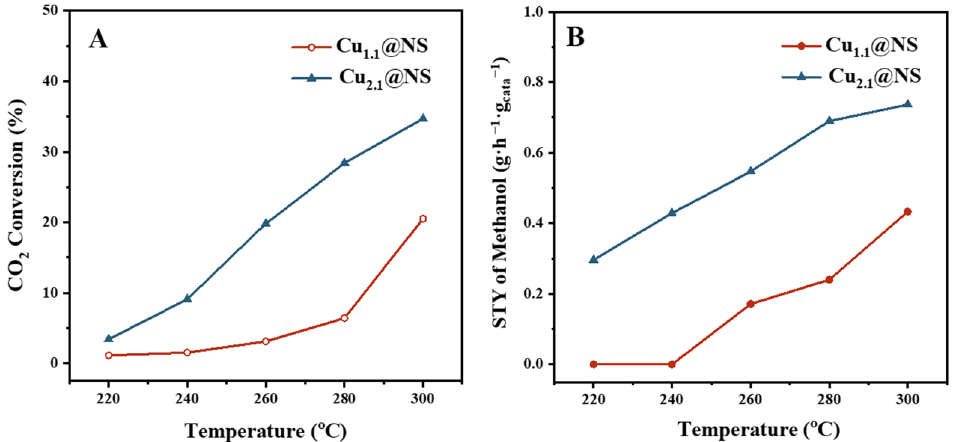
Figure 5. Catalytic test of CO 2 hydrogenation in the fixed-bed microreactor in CO 2 /3H 2 flow at GHSV = 2000 h − 1 and 3 MPa over Cu 1.1 @NS and Cu 2.1 @NS materials: ( A ) CO 2 conversion at various temperature; ( B ) space–time yield of methanol.